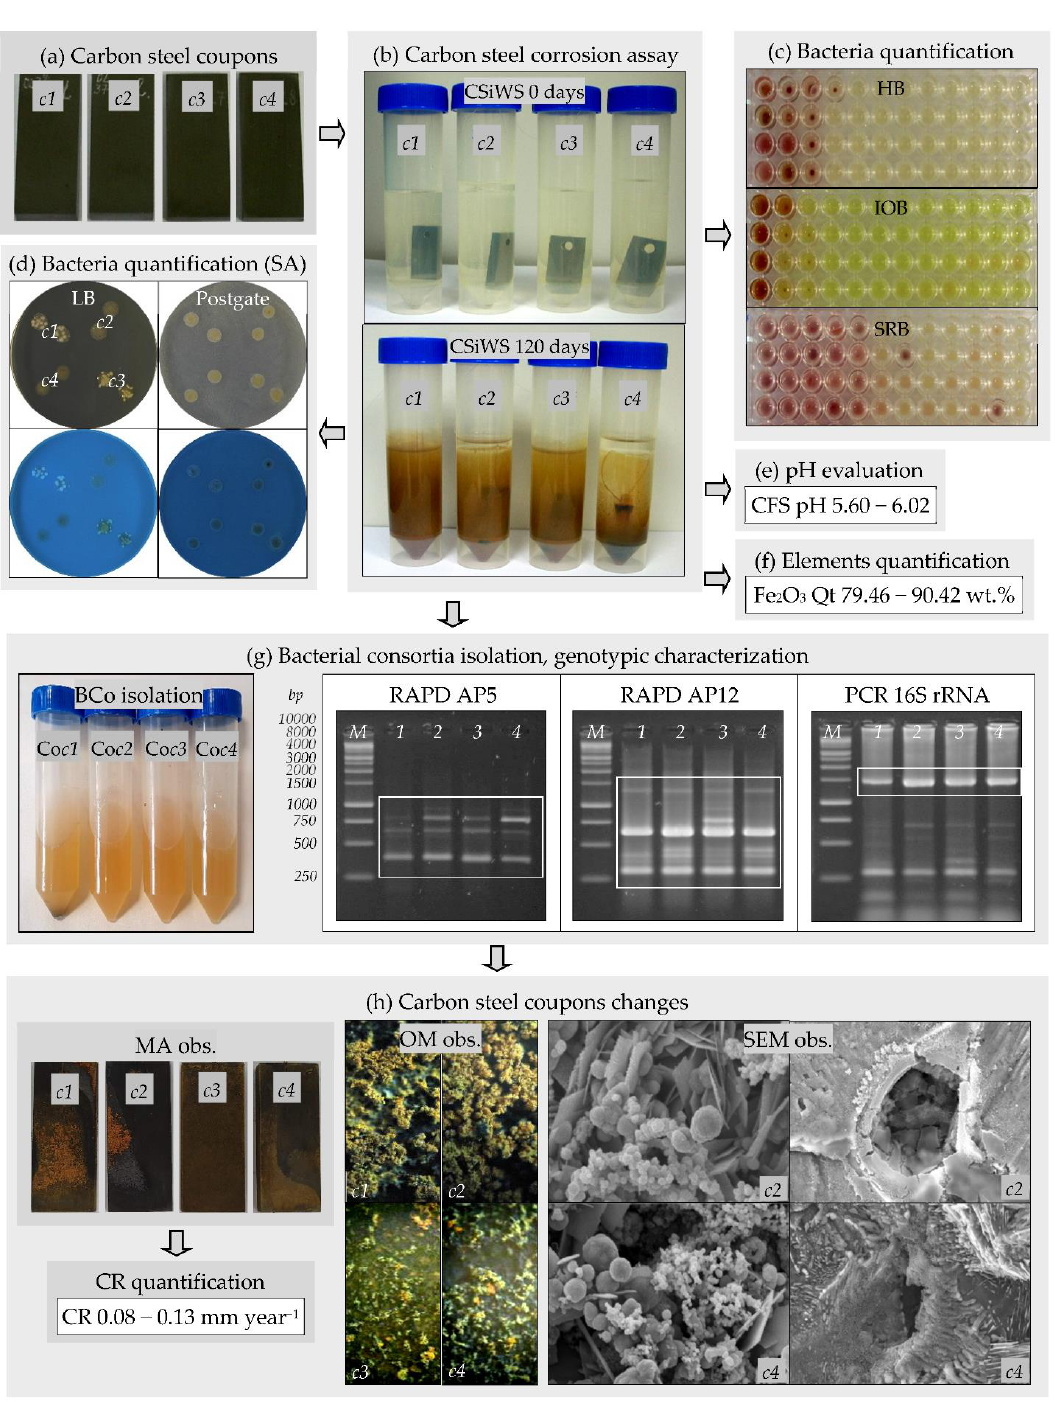
Figure 3. Biocorrosion of carbon steel coupons exposed to the water sample. ( a ) Carbon steel A570 ( c1 , c2 ), 1045 ( c3 , c4 ) coupons. ( b ) Carbon steel (CS) corrosion assay: CS A570 ( c1 , c2 ), 1045 ( c3 , c4 ) coupons immersed in the water sample (CSiWS) and incubated for 0 − 120 days under aerobic ( c1 , c3 ) or anaerobic ( c2 , c4 ) conditions. ( c ) Bacteria quantification (MPN assay): heterotrophic bacteria (HB), iron-oxidizing bacteria (IOB), sulfate-reducing bacteria (SRB). ( d ) Bacteria quantification (spot